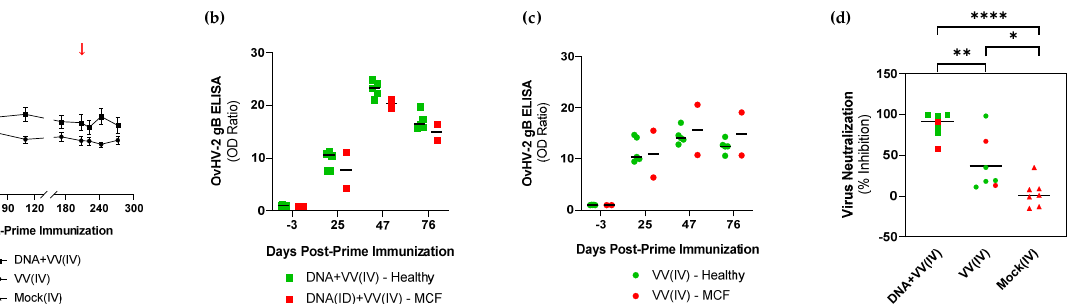
Figure 3. Anti-OvHV-2 gB antibody response in plasma of animals immunized with OvHV-2 DNA plus AlHV-1-vectored vaccine [DNA+VV(IV)], AlHV-1-vectored vaccine only [VV(IV)], or mock control [Mock(IV)] and challenged with OvHV-2 at 49 days post-prime immunization in Experiment 1. ( a ) Anti-OvHV-2 gB antibody responses pre- and post-immunizations and challenge measured by ELISA; error bars represent SEM and arrows represent immunizations (green) and challenges (red) times. ( b , c ) Individual anti-OvHV-2 gB antibody response in animals that remained healthy or developed SA-MCF following OvHV-2 challenge in the DNA+VV(IV) ( b ) and VV(IV) ( c ) groups; bars indicate the median. ( d ) Individual anti-OvHV-2 gB neutralizing antibody response measured by viral neutralization assay in each group at 46 days post-prime immunization; green symbols refer to animals that remained healthy after challenge and red symbols to animals that developed MCF; bars indicate mean; **** p ≤ 0.0001, ** p = 0.0022, and * p = 0. Antibody responses in rabbits that received the viral-vectored vaccine candidate delivered by intramuscular route (experiment 2) are shown in Figure 4. All three immunized rabbits developed anti-OvHV-2 gB IgG antibodies following immunizations (Figure 4a).